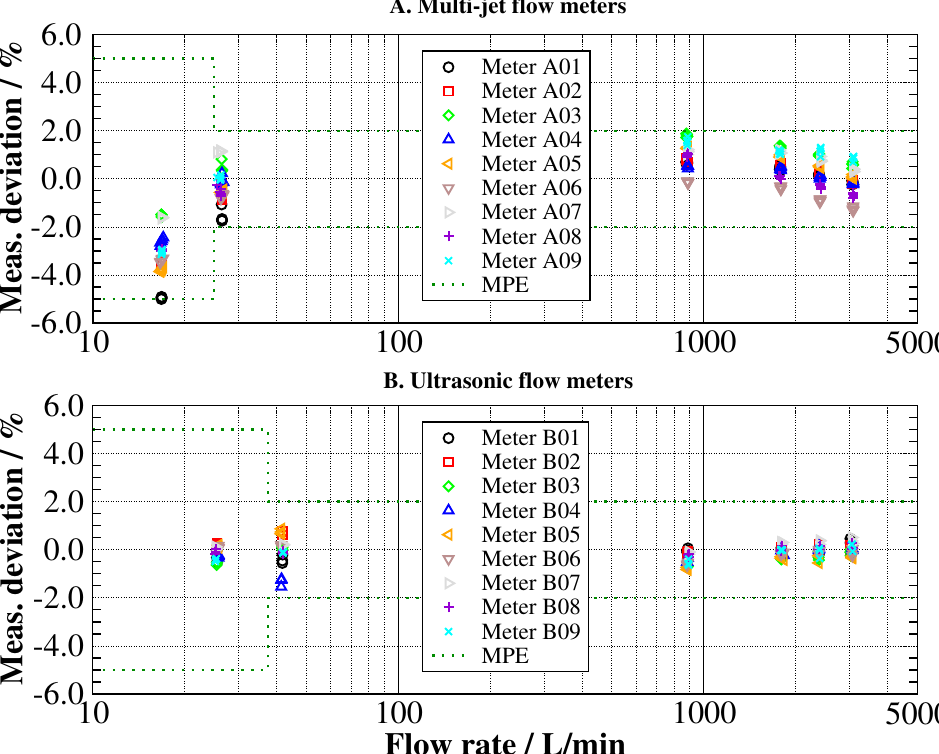
Figure 4. Top: ( A ). Calibration results of the B meters multi-jet cold water meters before the hard- ness tests; Below: ( B ). Calibration results of the Kamstrup ultrasonic cold water meters before the hardness